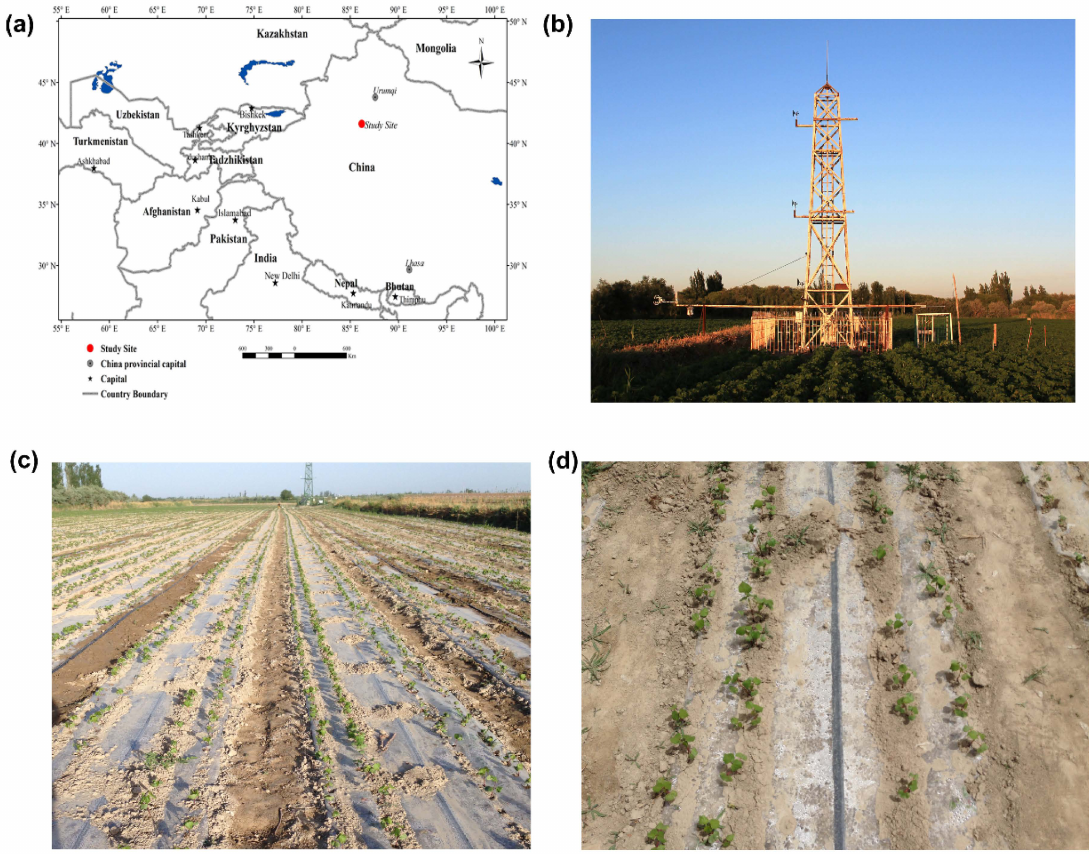
Figure 1. The location and eddy covariance system of the study area: ( a ) the location of the study areas; ( b ) the observing tower in the field; ( c , d ) the cotton under mulched drip irrigation and one-film, one-pipe, four-row